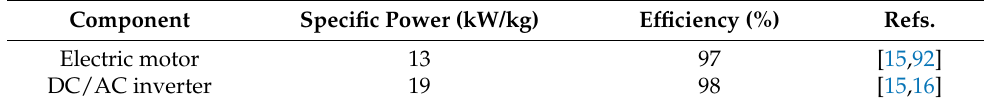
Table A2. Specifications for the electric components in the hybrid-electric aircraft . Component Specific Power (kW/kg) Efficiency (%) Refs. Electric motor 13 97 [15,92] DC/AC inverter 19 98